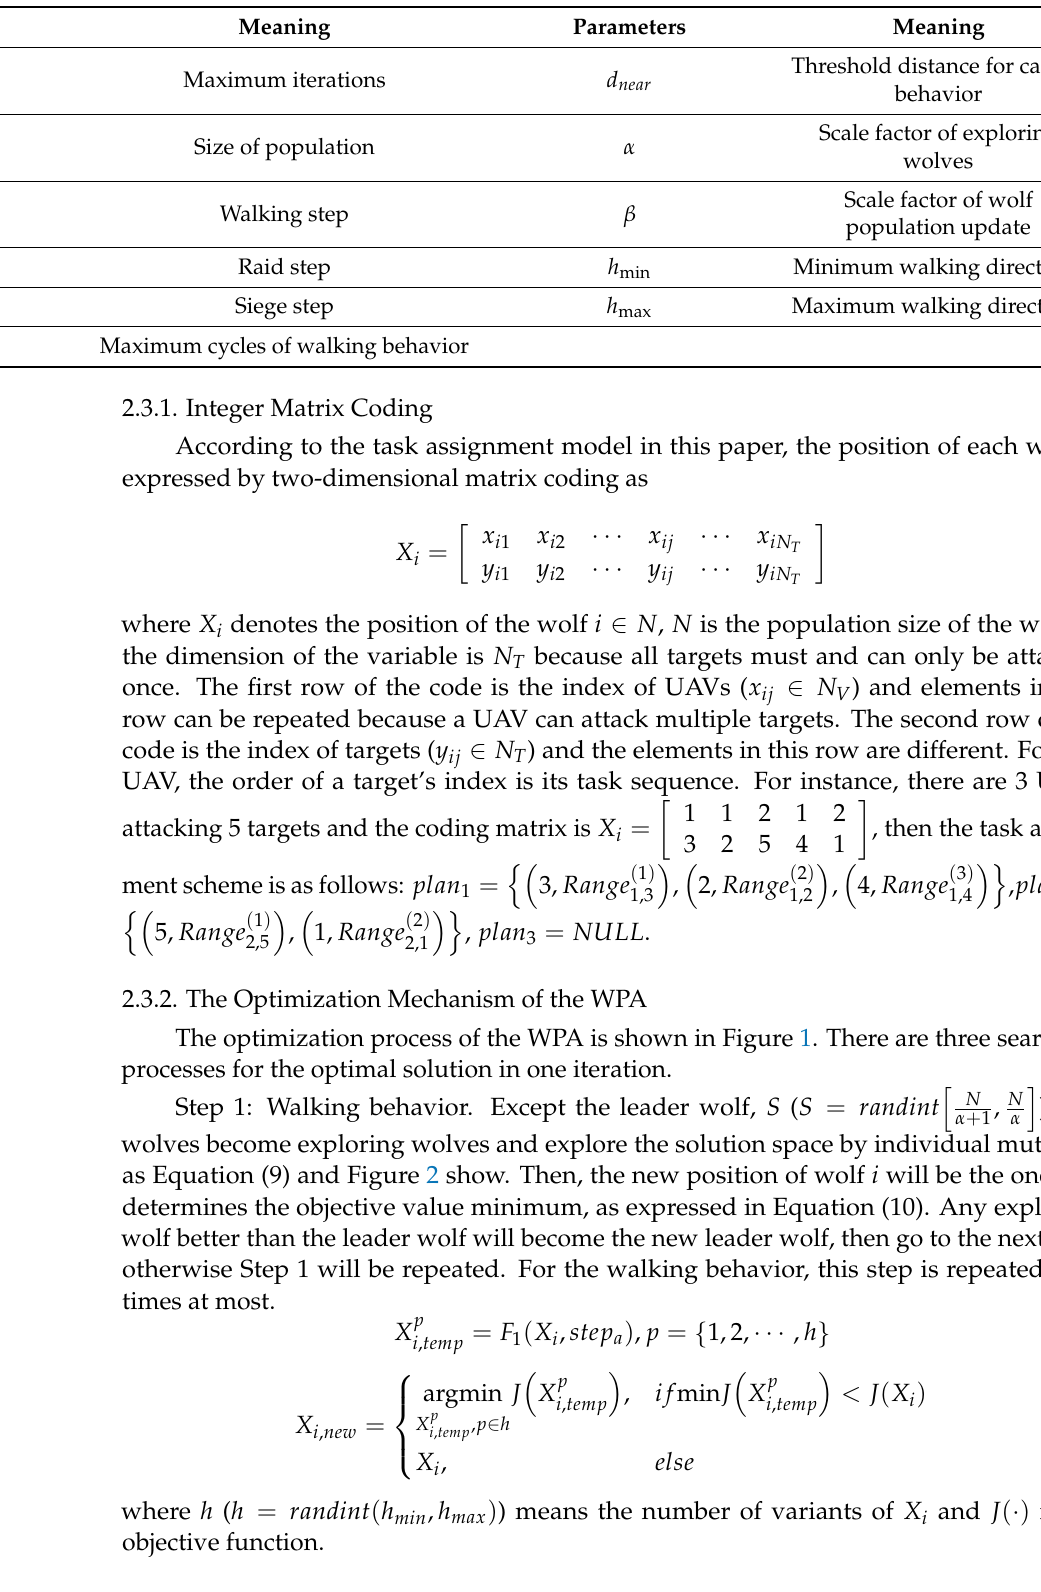
Table 1. Parameters of WPA and